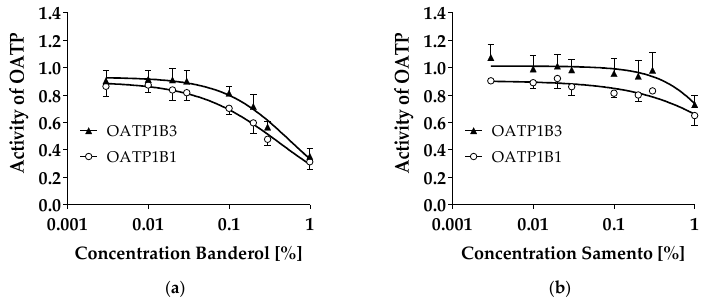
Figure 1. Concentration-dependent effect of Samento and Banderol on intracellular 8-cAMP fluorescence in HEK293 cells over-expressing organic anion transporting polypeptide (OATP)1B1 and OATP1B3, respectively, normalized to the mock-transfected control cell line. Data depict a biological triplicate ± S.E.M. with 30,000 cells measured by flow cytometry for each concentration in each experiment. ( a ) OATP inhibition by Banderol. ( b ) OATP inhibition by